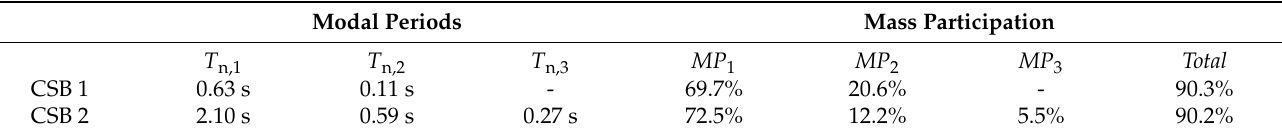
Table 3. Modal periods (Tn) and mass participation (MP) for the case study